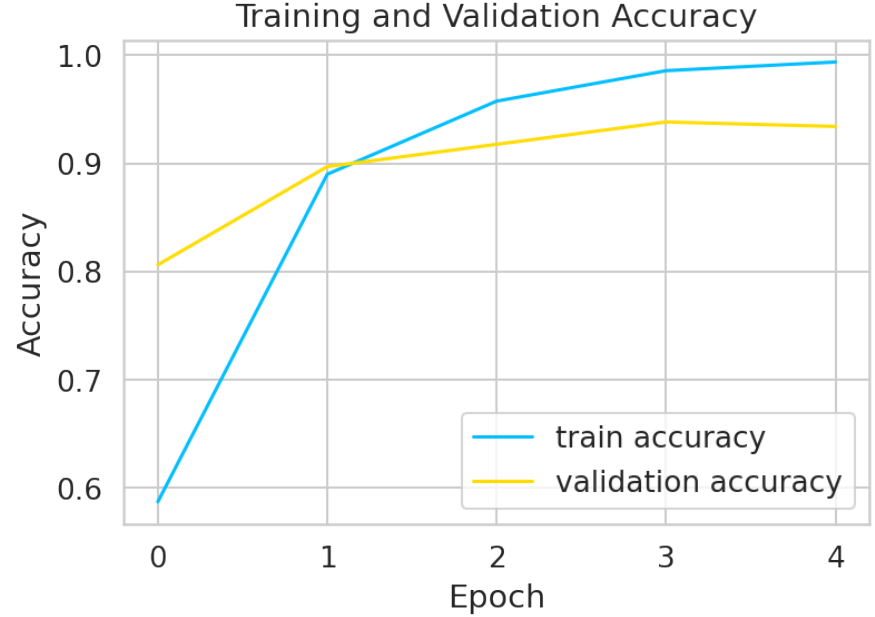
Figure 13. Training and validation accuracy for BERT.